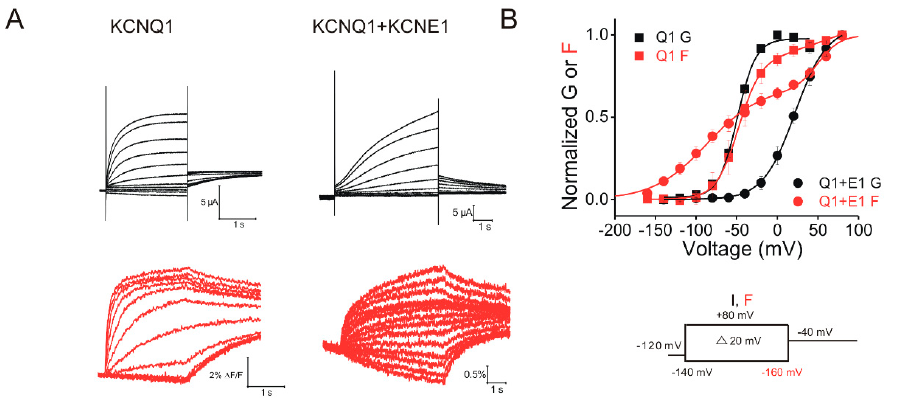
Figure 3. Voltage-clamp fluorometry recordings of KCNQ1 and KCNQ1 / KCNE1 channels. ( A ) Representative current (black) and fluorescence (red) traces from KCNQ1 and KCNQ1 / KCNE1 channels in response to the indicated voltage protocol (right). Cells are held at − 120 mV and stepped to voltages between − 140 ( − 160 mV for fluorescence) and + 80 mV in + 20 mV followed by a step to − 40 mV. ( B ) Voltage dependence of currents (black) and fluorescence (red) from KCNQ1 (squares) and KCNQ1 / KCNE1 (circles) channels. KCNE1 shifts the voltage dependence of the current activation of KCNQ1 to more positive voltages and separates the voltage sensors movement of KCNQ1. This suggests that S4 in KCNQ1 / KCNE1 moves in two